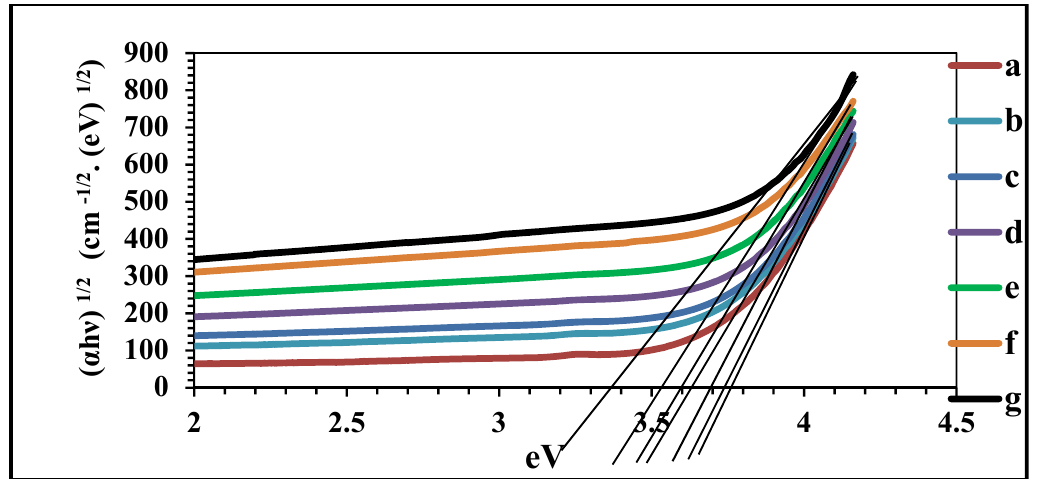
Fig .7: Indirect transition band optical energy gap solid films of PVA\CuI composites with different concentrations of CuI. (a) 0wt% (b)1wt% (c)3wt% (d)5wt% (e)7wt% (f)9wt% (g)20wt%.